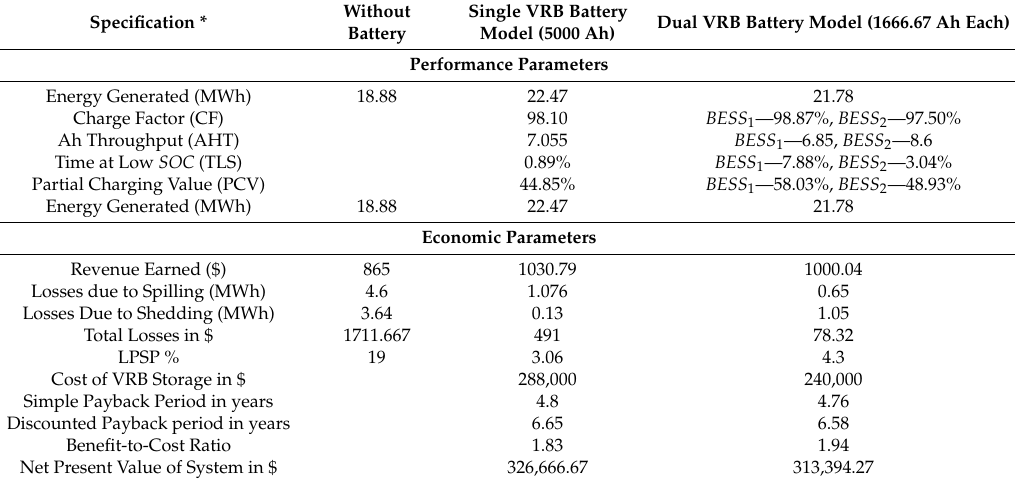
Table 5. Comparison of HRES based on simulated